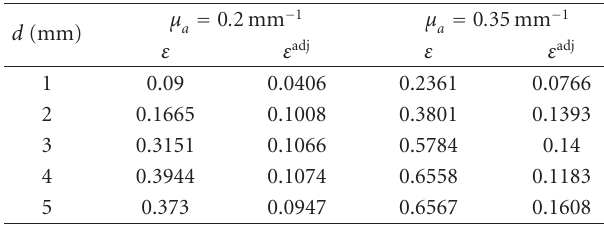
Table 3: Accuracy improvements of DA regarding to di ff erent light source locations. d is the distance from the origin, ε the error with- out optical parameter optimization, and ε adj the improved error.